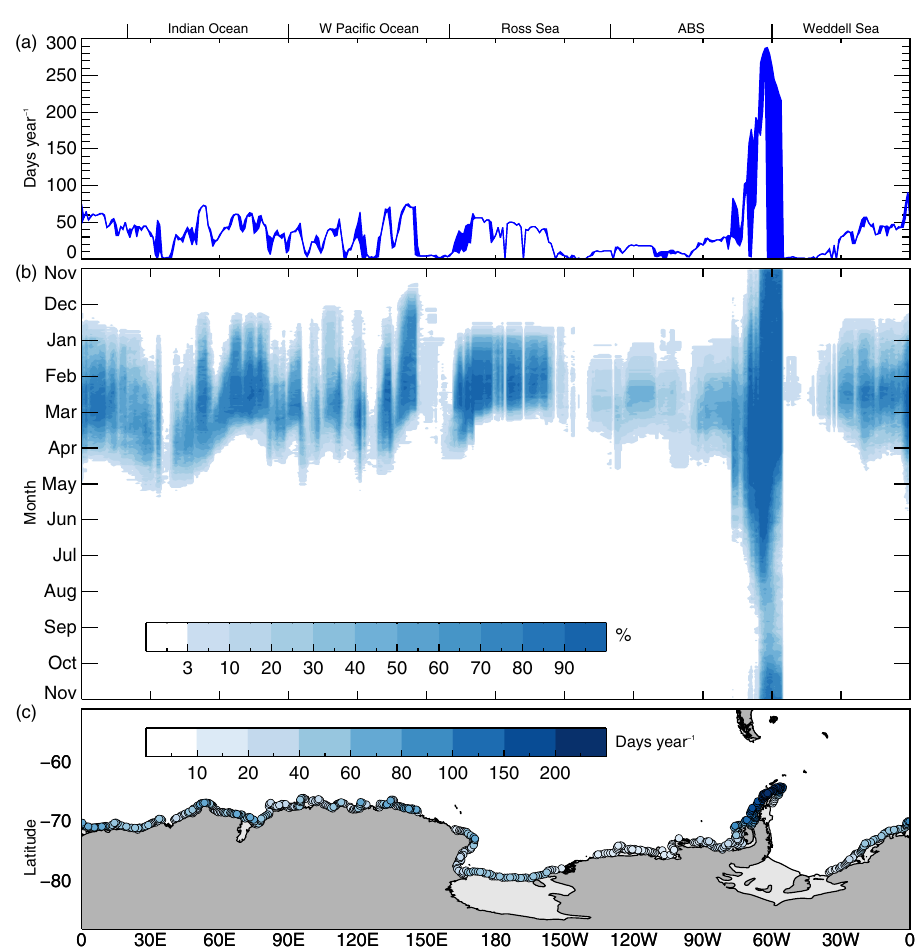
Fig. 2 Climatology (1979 – 2020) of coastal exposure events based on coastal exposure length. a Annual exposure duration for each longitude (days year − 1 ); b coastal exposure occurrence expressed as a percentage of frequency for each day and longitude (%); and c annual exposure for each grid point (days year − 1 ). Shaded blue lines in ( a ) represent the variability (maximum and minimum) for each longitude. Grid points in ( c ) are arranged such that those with higher lengths of exposure are plotted over those with lower